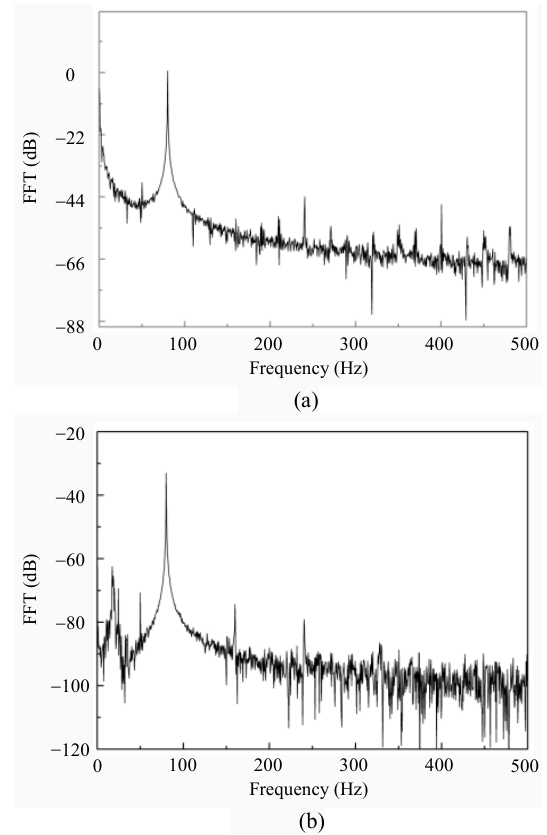
Fig. 9 Frequency responses of the demodulated vibration signals by (a) fiber sensor and (b)